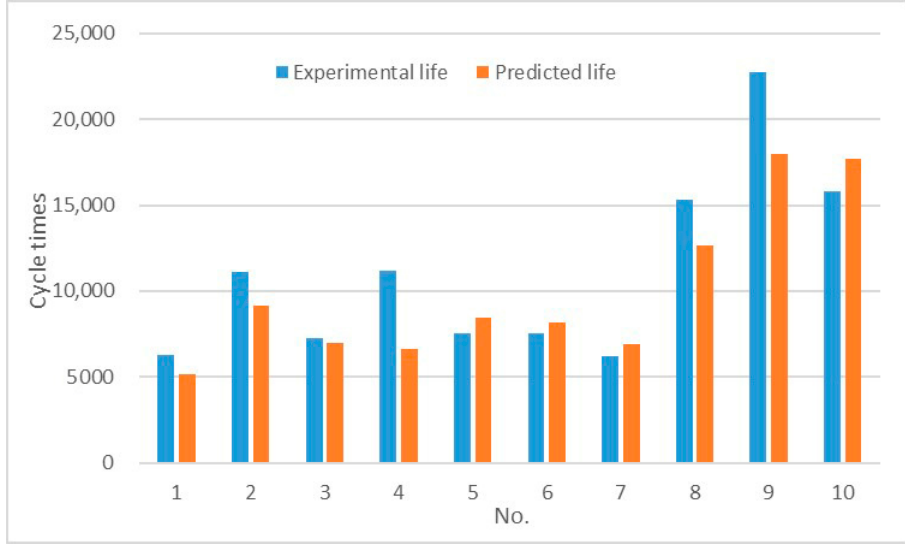
Figure 14. Experimental life vs. Predicted life.